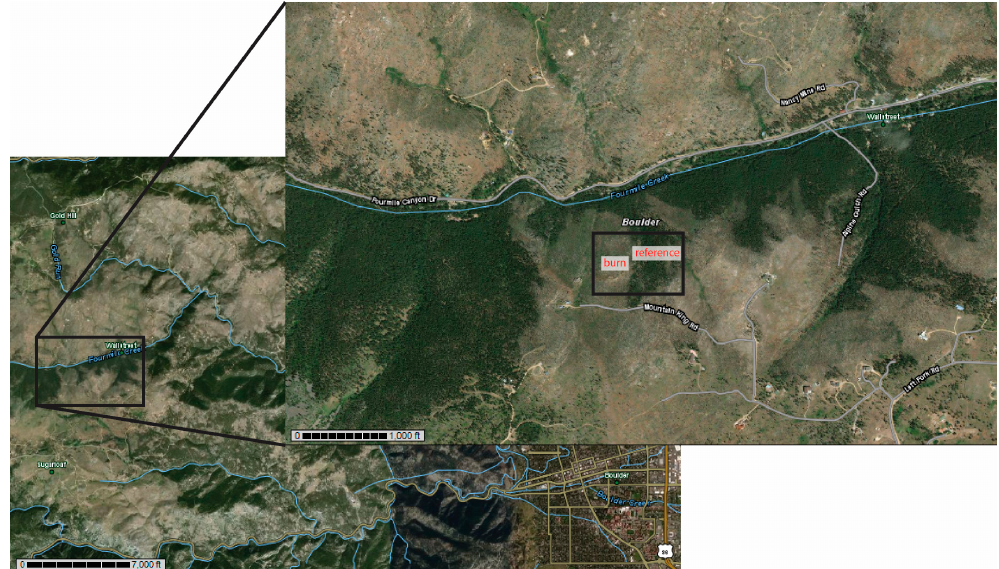
Figure 1. Maps of Boulder and Fourmile Canyon and surrounding region, with sample area demarcated in inset map. Maps are from the U.S. Department of Agriculture Natural Resources Conservation Service.